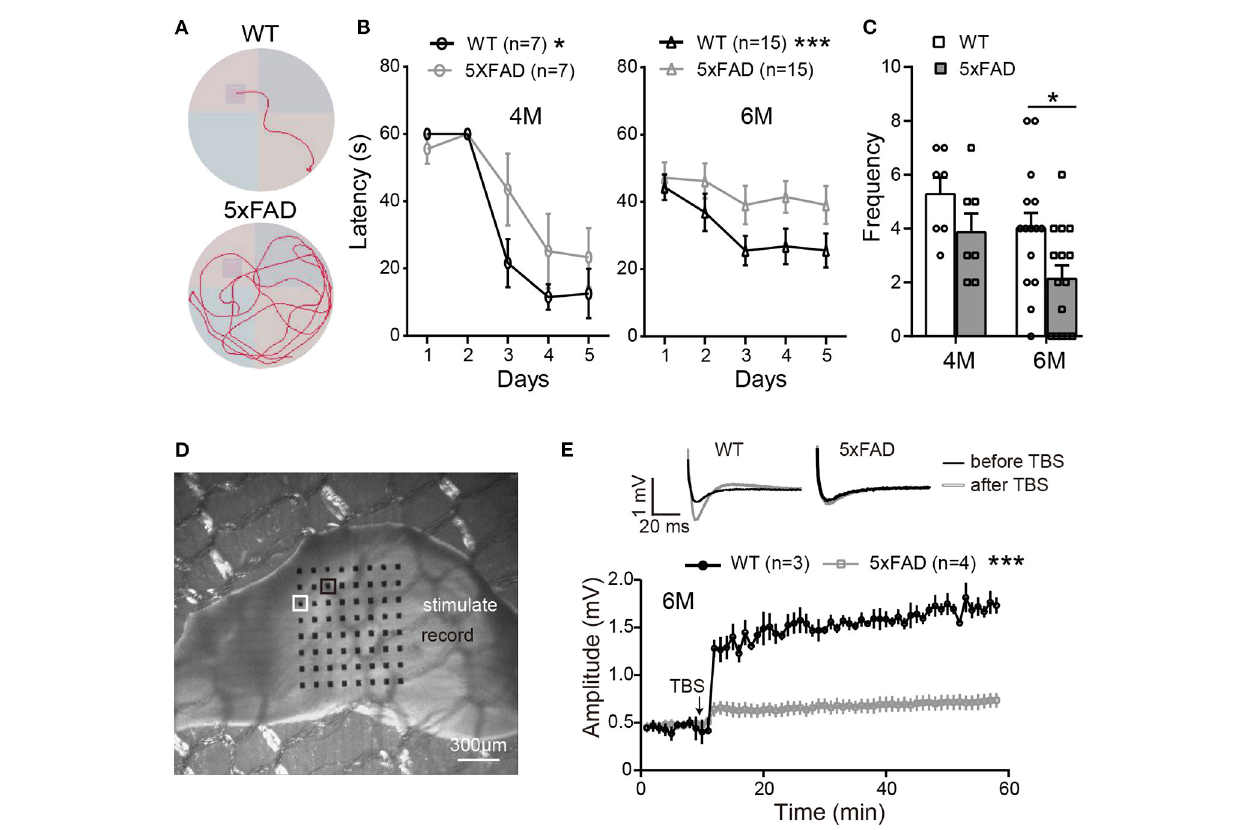
FIGURE 1 | The working memory and LTP deficiency in 5xFAD mice. (A) Swimming traces of a WT and 5xFAD mice in the water maze, with the hidden platform in the upper-left quadrant. (B) The latency for mice to reach the platform during the first 5 days of trials at 4 and 6 months. (C) The frequency of mice crossing the platform region on the test day. 5xFAD mice at 6 months took longer time to locate the platform during the trial day and crossed the platform region less frequently than WT. (D) Illustration of a mouse hippocampus slice placed on the 8 × 8 multielectrode array. One of the electrodes (white squared) was used to apply the electric stimuli; the other electrodes recorded the evoked field potential; the electrode squared in black, which gave the best response, was selected for data analysis. (E) Average changes in the amplitude of the evoked post-synaptic potential (EPSP) within 45min after the theta-burst stimulation (TBS) in WT and 5xFAD mice. Typical EPSP of a WT and 5xFAD mice before (black line) and after (gray line) TBS stimulation at an expanded time scale are shown above. n, number of experimental animals. Data shown as mean ± SEM. * p < 0.05; *** p < 0.001; two-way